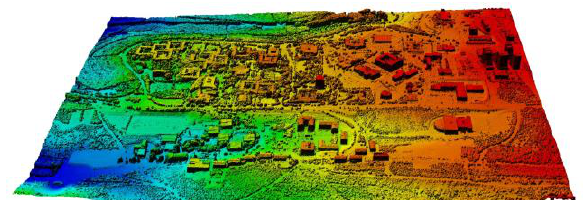
Figure 2. Overview of the generated DSM